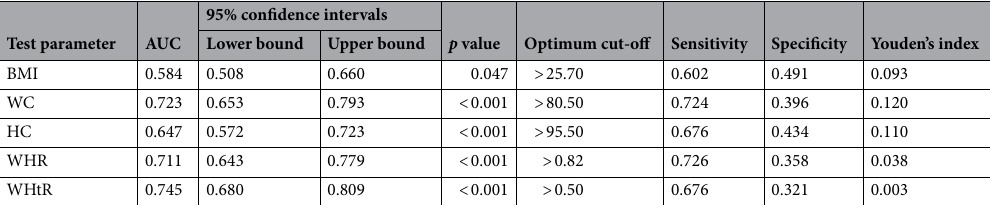
Table 3. The AUC and the optimum cut-off points of anthropometric indices with VF levels in diabetic